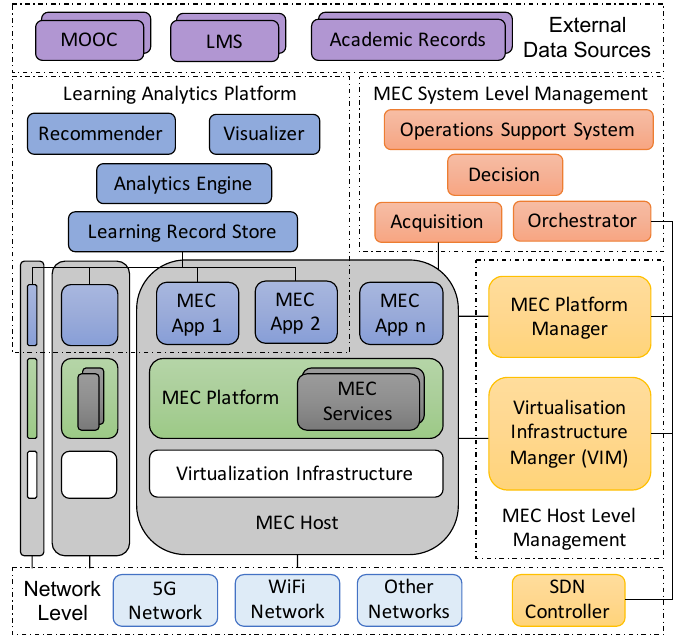
Figure 1. Architecture oriented to the Mobile Edge Computing (MEC)